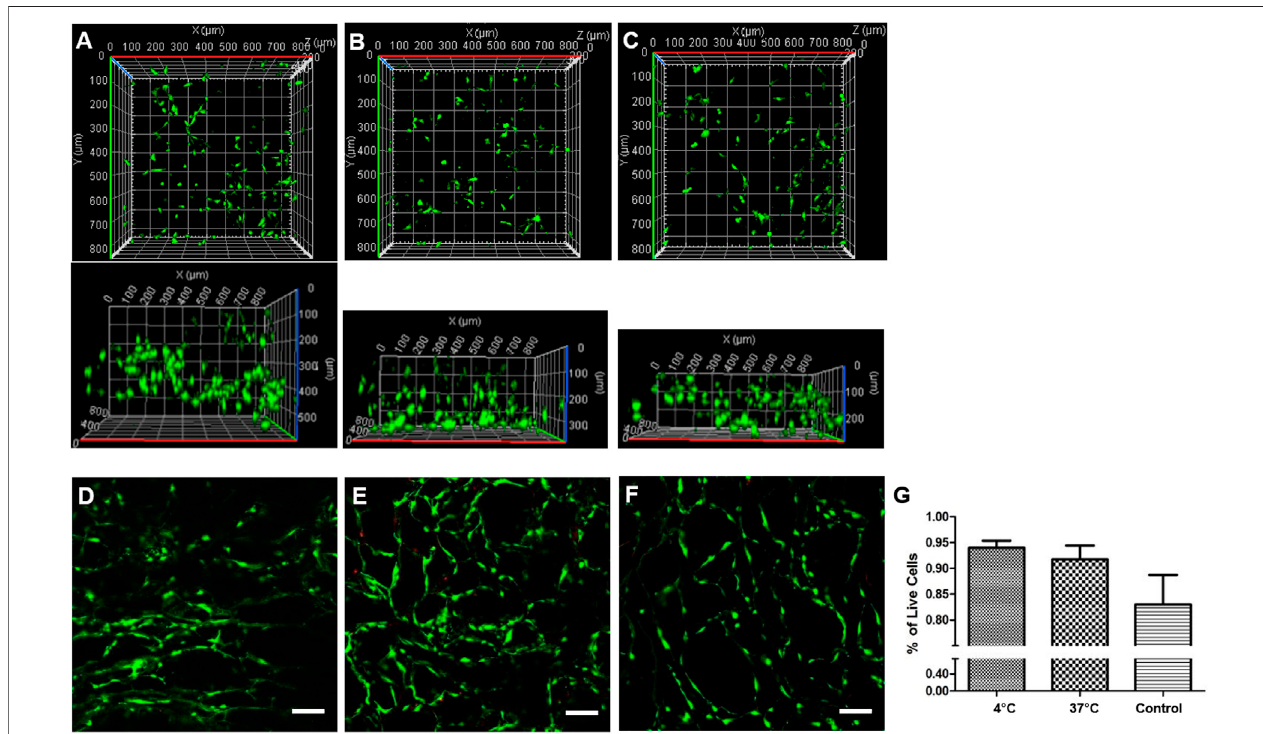
FIGURE3| Fibronectincoatingconformationaffectscellinvasionandviability.3DviewofGFP-labeled3T3cellsdistribution withinColscaffoldsinitiallycoatedwith Fnat4 ° C (A) ,37 ° C (B) ,orleftinPBS(control,noFn)atroomtemperature (C) priortoseeding.3T3-L1cellsviabilitywasquanti fi ed via Live/Deadassayforallscaffolds,at 4 ° C (D) , at 37 ° C (E) or control (F) after 24 h incubation. Live cells were stained with calcein (green), and dead cells were stained with propidium iodide (red). Scale bar = 100 μ m. Live cells number per volume was quanti fi ed in percentage for all scaffolds (G)